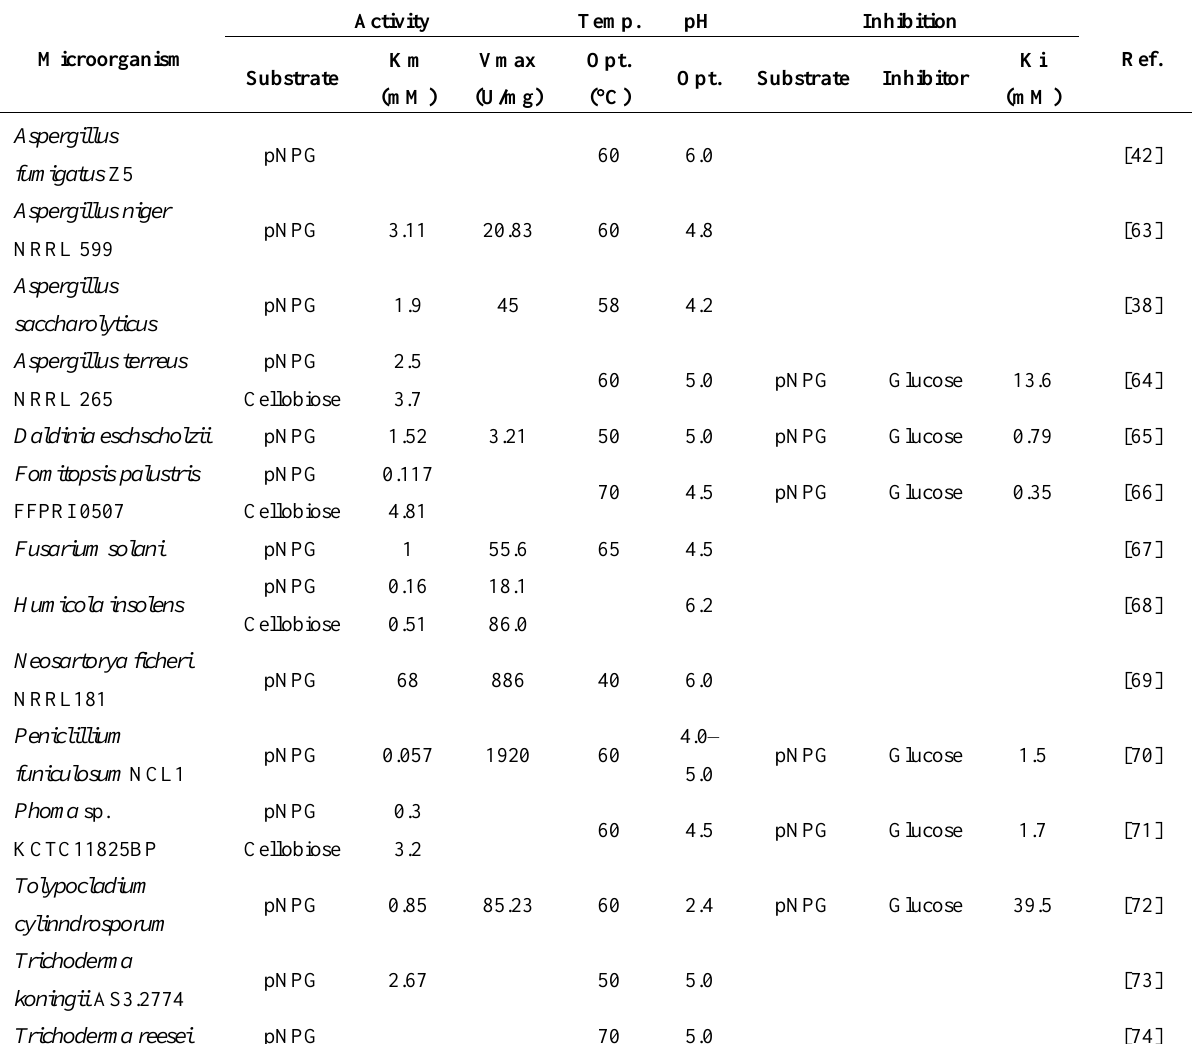
Table 1. Beta-glucosidases and their